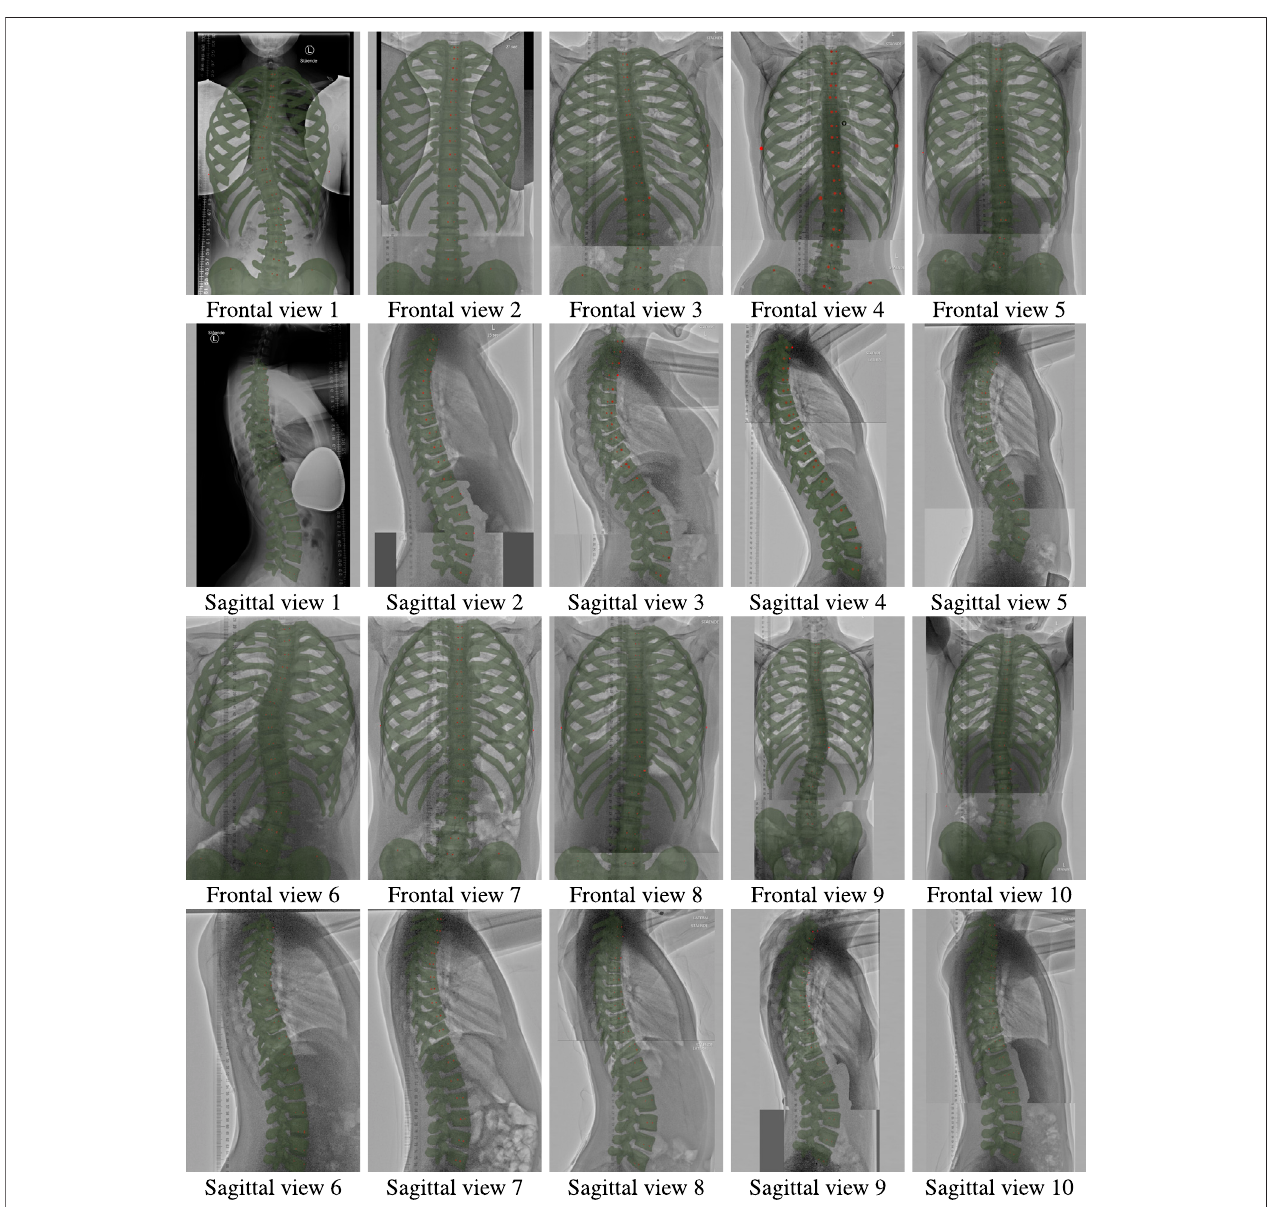
FIGURE 2 | Frontal and sagittal views of all ten patients of the study, with the morphed models overlaid on the input radiographs.